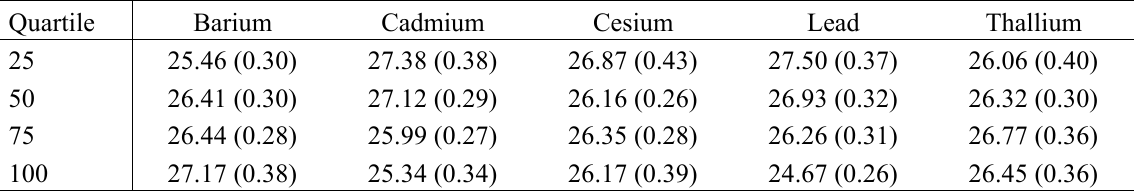
Table 5. BMI by Metal Quartiles for All Participants.